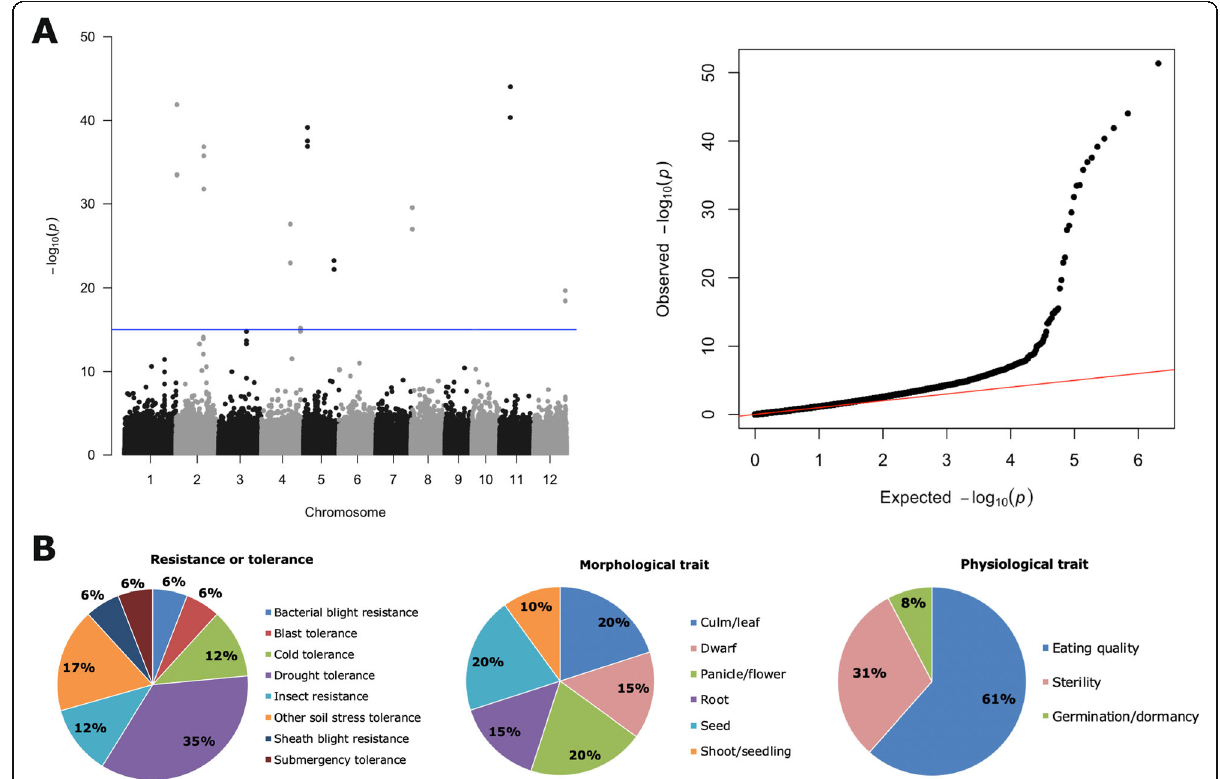
Fig. 3 Rice metabolic pathways are associated with the microbiome structure. a Genome-wide association for the 12 microbial hubs simultaneously using a multivariate linear mixed model with GEMMA software. Left panel, Manhattan plot, using the rice dataset, indicated the major peaks (significant SNPs) distributed across six chromosomes, associated with microbial abundance of the 12 hubs. Right panel, Quartile – quartile plot for expected versus observed − log(P) values. P -values were adjusted with FDR and values lower than 1E-15 were consider significant (blue line). b the significant SNPs found in this study co-localized with a number of agronomic QTLs retrieved from Q-TARO database, associated with resistance or tolerance; morphological trait; and physiological